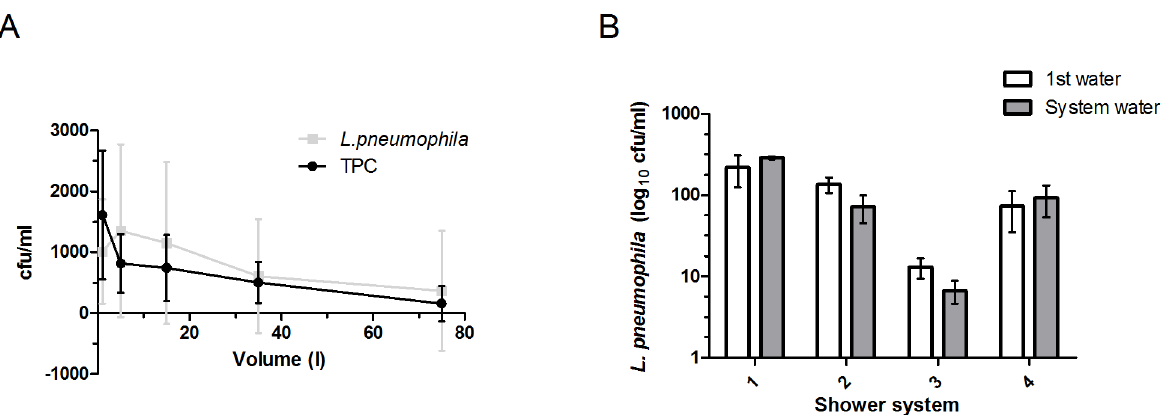
Fig. 3. Shower head water compared to system water. A) Concentrations of L. pneumophila and TPC of 9 showers at School 1. The sampling volume was 50 ml. The number of samplings per point varied from N 5 16 to N 5 8. B) Distribution of L. pneumophila in different water fractions of 4 shower systems. The white column shows the concentration in the first water collected from the shower head and the grey column the concentration in the system water. There is no statistical difference between the two fractions in any of the systems (nonparametric t-test, P .